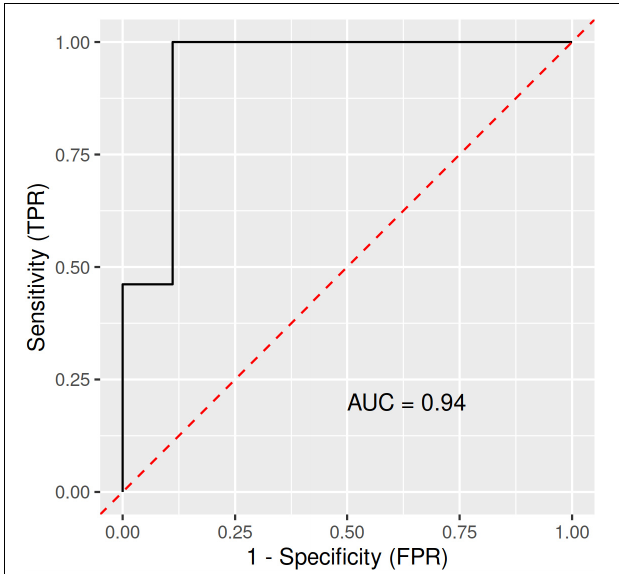
FIGURE 5 | ROC (receiver operating characteristic) curves with an area under the ROC curve (AUC) for the RFM-L algorithm with Bacteroides , Prevotella , Intestinimonas , Subdoligranulum , and the Bacteroides to Prevotella ratio as joint predictors/discriminators between the LA and CTRL groups. FPR, false-positive rate; LA, lifetime elderly endurance athletes; CTRL, controls; RFM-L, random forest machine-learning; TPR, true positive rate.